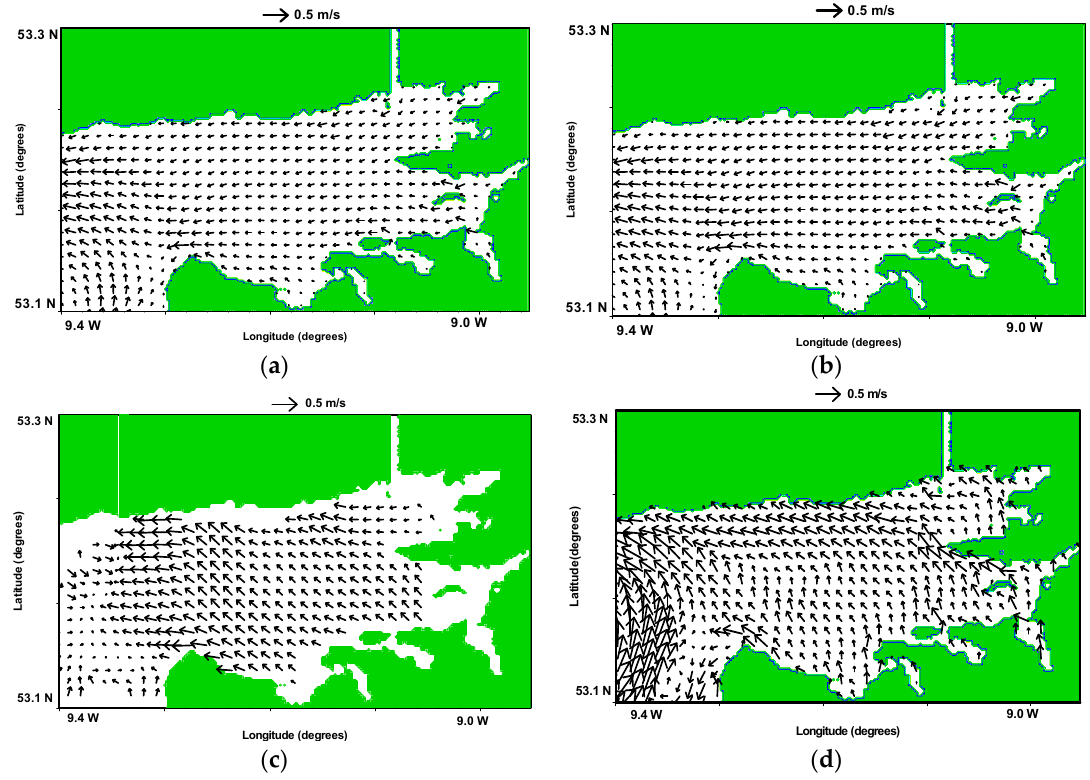
Figure 18. Mid-ebb vector fields (( a ) Depth-averaged currents from model NW; ( b ) surface currents from model NW; ( c ) CODAR current data and ( d ) surface currents from model HR).